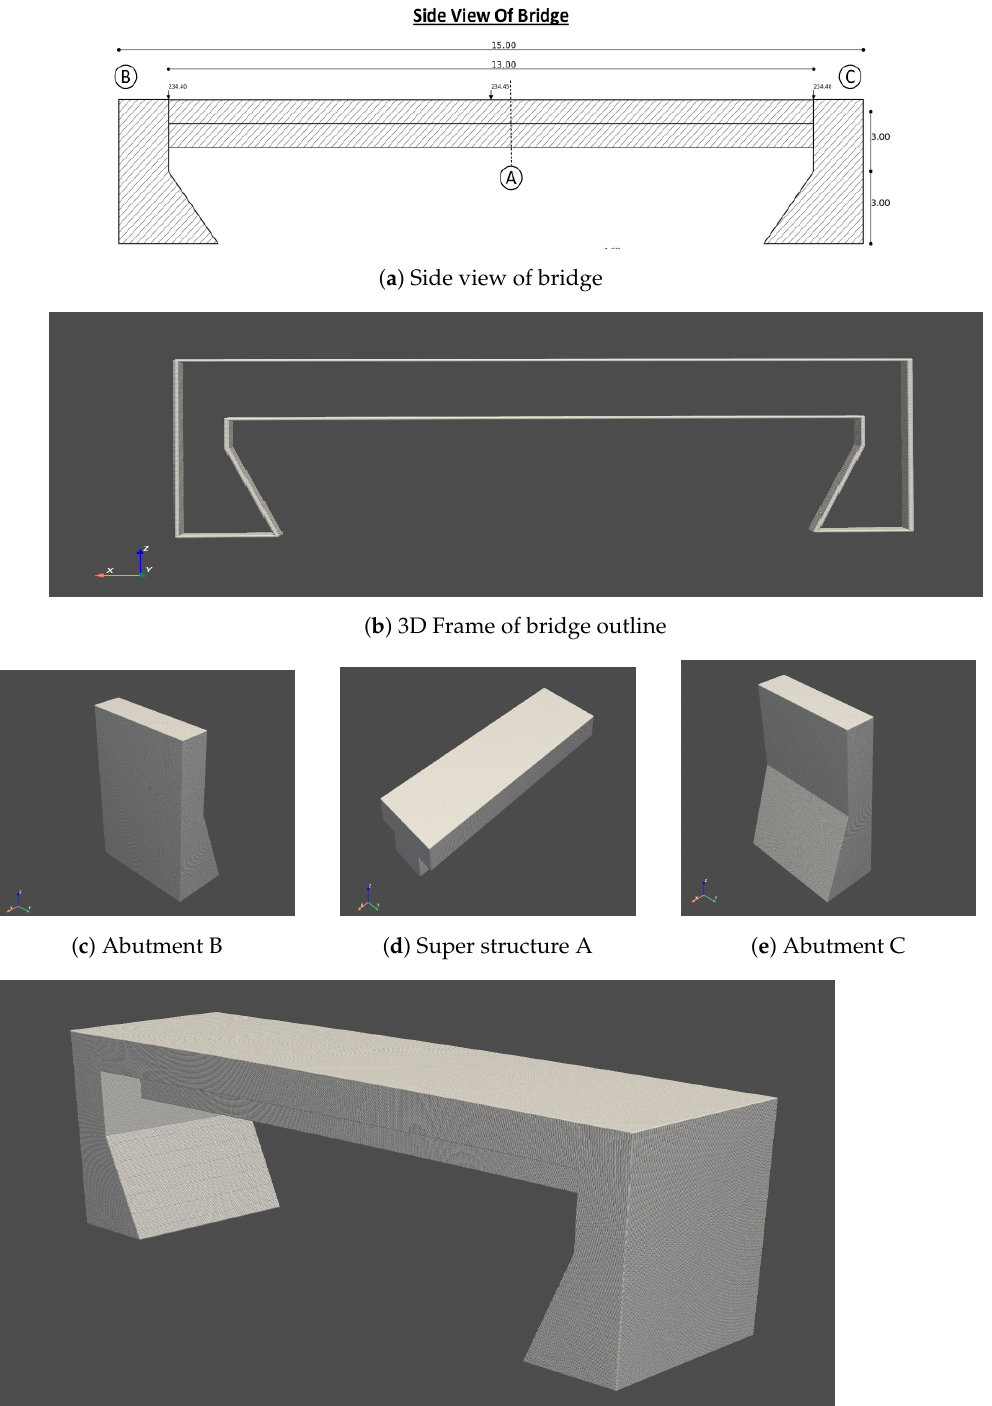
Figure 8. 3D point cloud fused from the various parts. ( a ) is used as the reference to generate ( b ) a 3D frame of the bridge for the fusion of ( c – e ) to create ( d ) a fully reconstructed